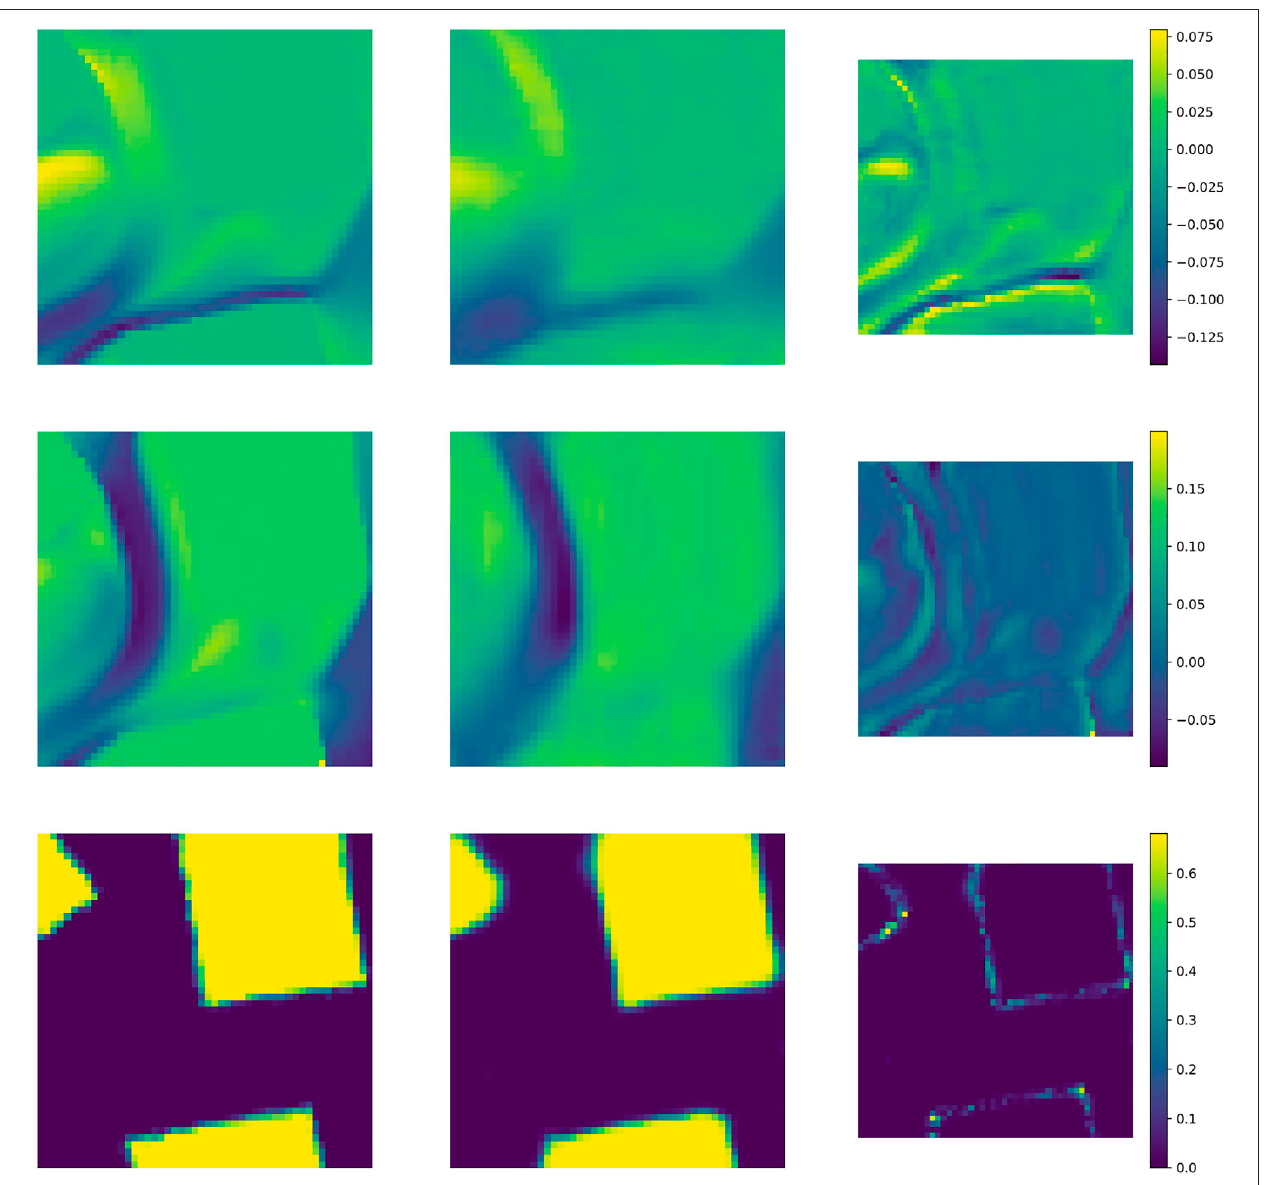
FIGURE5| Plots todemonstratethequalityoftheautoencoders. The(unseen) solutionsassociatedwithonesubdomainarecompressed andreconstructed.Left column: results from the HFM; central column: reconstruction from the CAE; right column: pointwise difference. Top row: x − component of velocity; middle row: y − component of velocity; bottom row: buildings fi